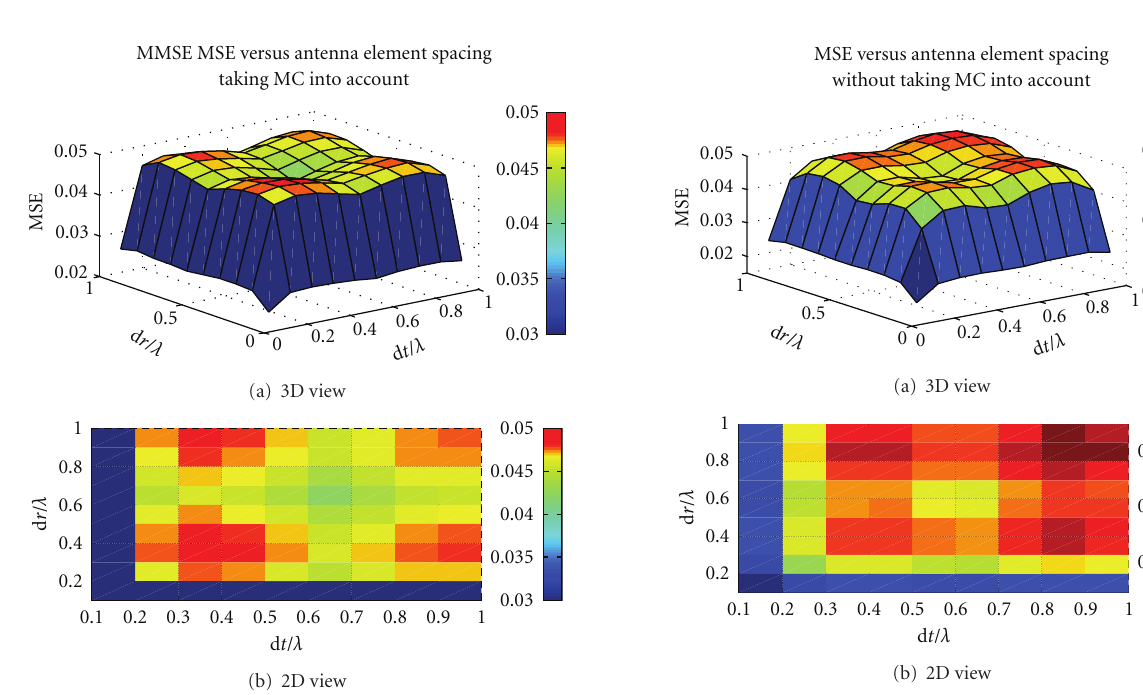
Figure 3: MMSE MSE versus transmitter and receiver antenna element spacing taking MC into account.